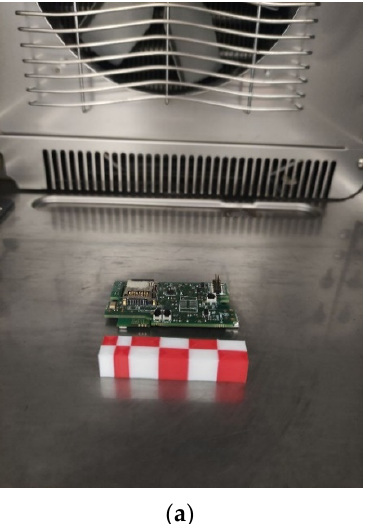
Figure 5. Experimental setup used in laboratory to characterize the IoT-based measurement system: ( a ) sensor inside climate chamber for relative humidity and temperature, ( b ) sensor on copy structure on the shaker.